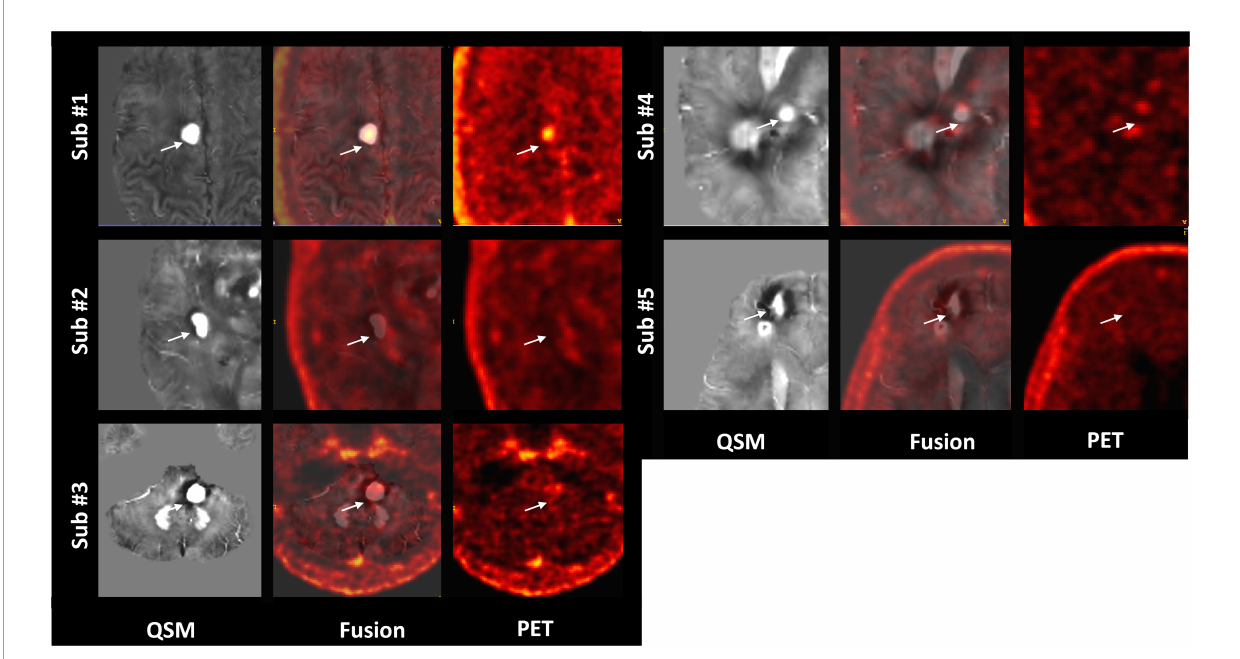
FIGURE5 Representative QSM and matched flutriciclamide PET images demonstrate the heterogeneity of the CCM lesions for all CCM patients. The white arrow is pointing to the location of the